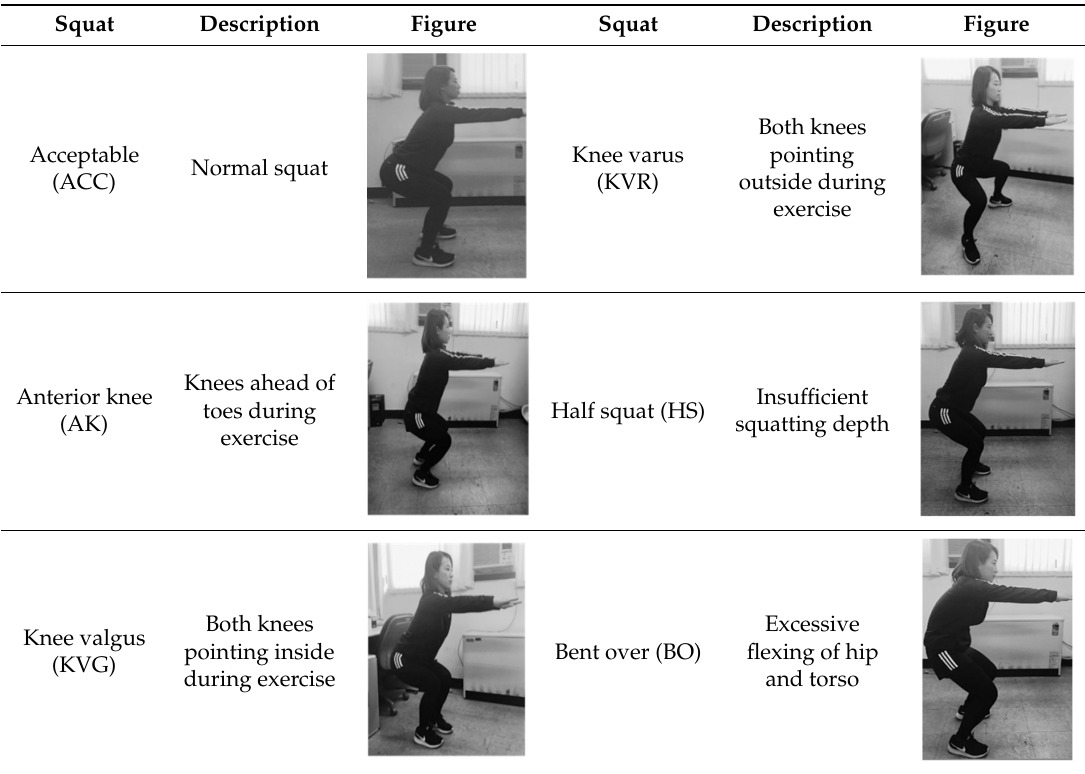
Table 1. Squat classification showing one acceptable and five aberrant